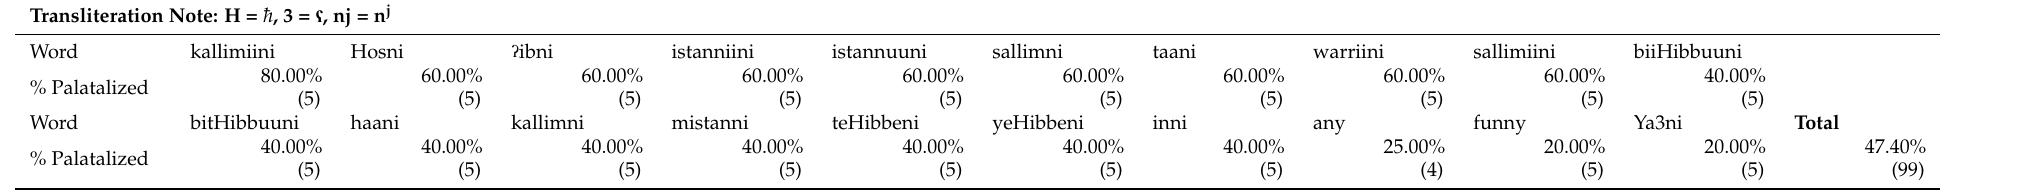
Table 3. Token count and percent palatalized by word (includes five of seven speakers); see Appendix A for gloss.